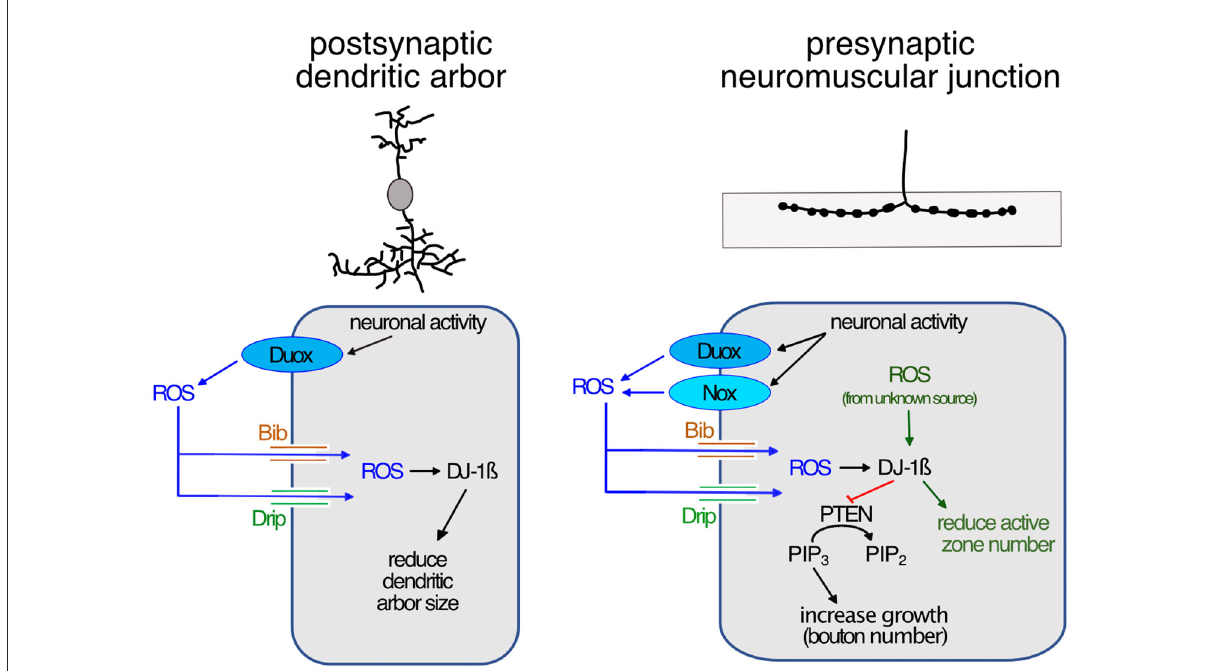
FIGURE4 Model of activity-regulated plasticity at the postsynaptic dendritic arbor and the presynaptic neuromuscular junction mediated by ROS signaling. Neuronal activity leads to activation of calcium-regulated NADPH oxidases in synaptic terminals; of Duox only in postsynaptic dendrites, while at the presynaptic neuromuscular junction both Duox and Nox are activated. Extracellularly generated ROS reintroduced into the cytoplasm via aquaporin channels, including Bib and Drip. This leads to reduced dendritic growth, while at the presynaptic neuromuscular junction ROS promotes growth by modulating PI3Kinase signaling at the plasma membrane via oxidation of DJ-1ß. Oxidized DJ-1ß increases binding and inhibition of the PTEN phosphatase, thus causing increased PI3Kinase signaling activity, stimulating growth and addition of synaptic release sites. ROS from unknown sources regulate the active zone